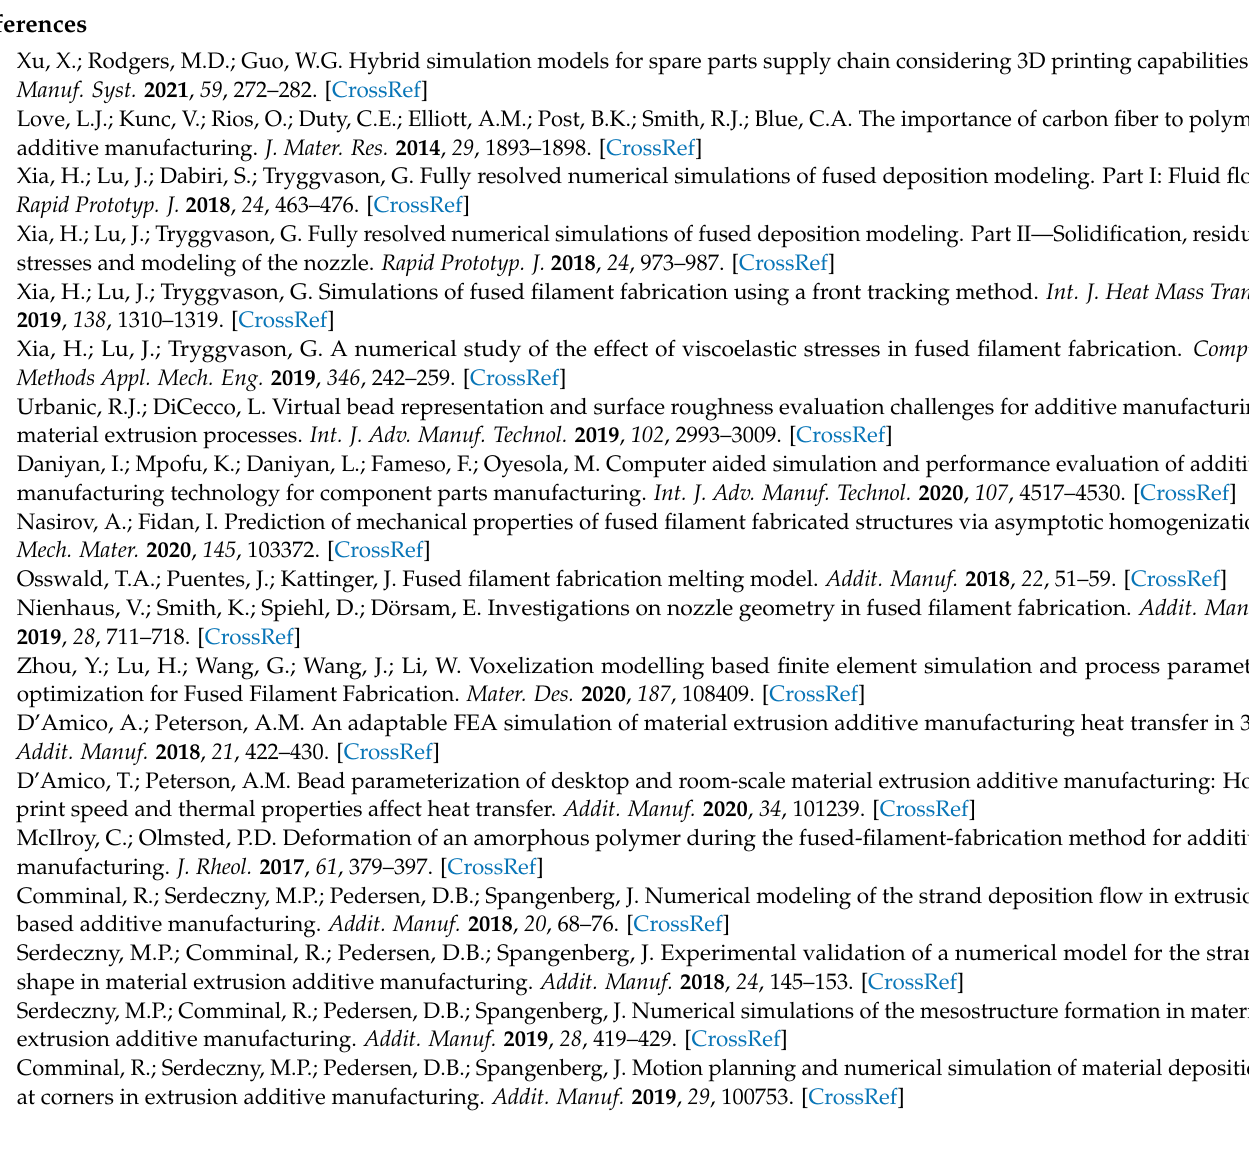
Figure A4. Outlines of the predicted extrudate swell of the deposited bead.